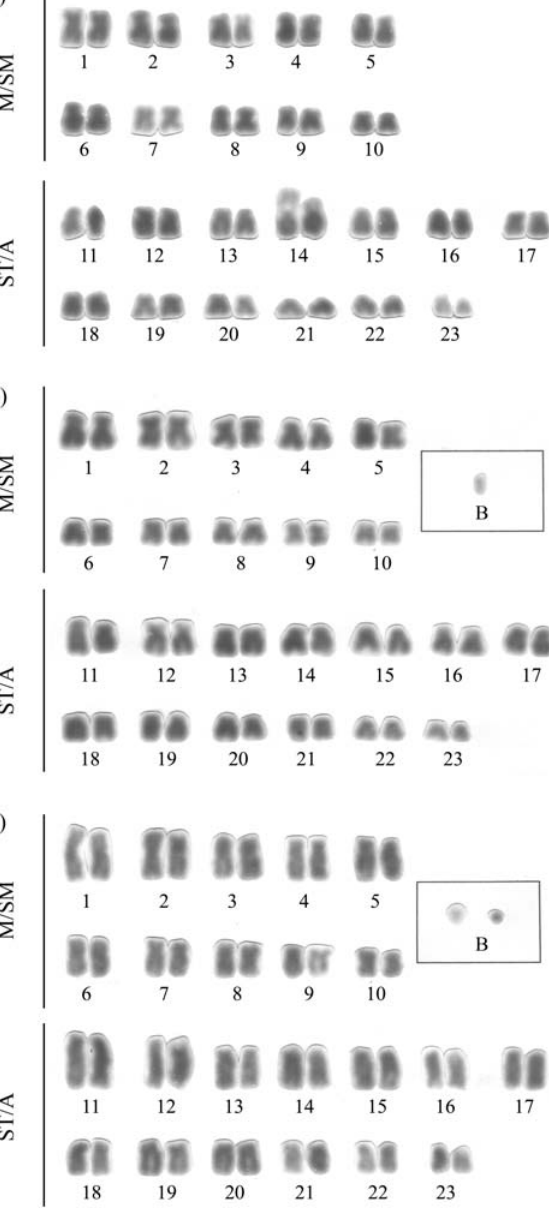
Figure 1 - Karyotype of Sphoeroides spengleri (Tetraodontidae) in (a). In (b) one B microchromosome is shown in detail, and in (c) two B micro- chromosomes are shown in